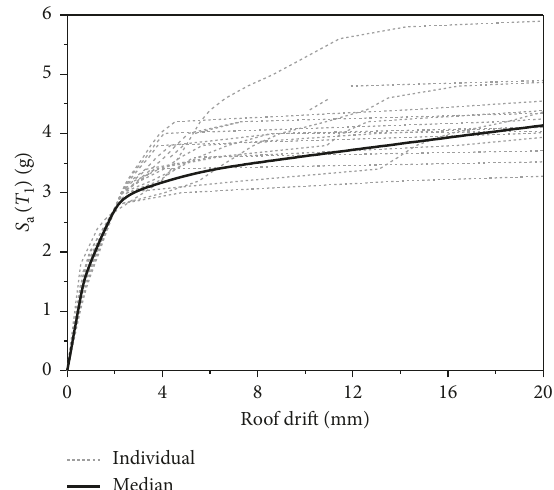
Figure 35: Performance curves based on pushover analysis.